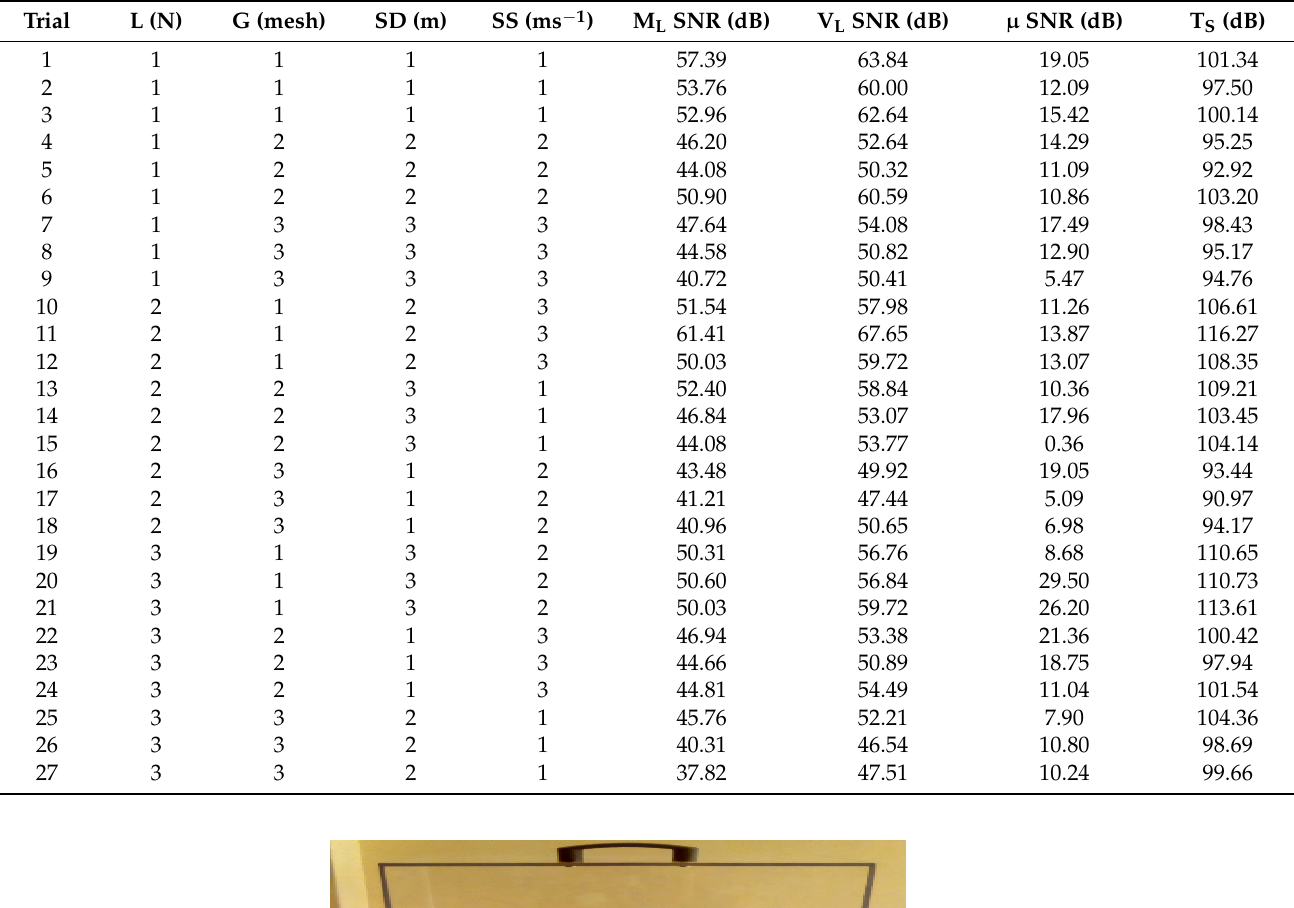
Table 3. Signal noise ratio of against SiC particle based on Taguchi L 27 (3 4 ) OA.